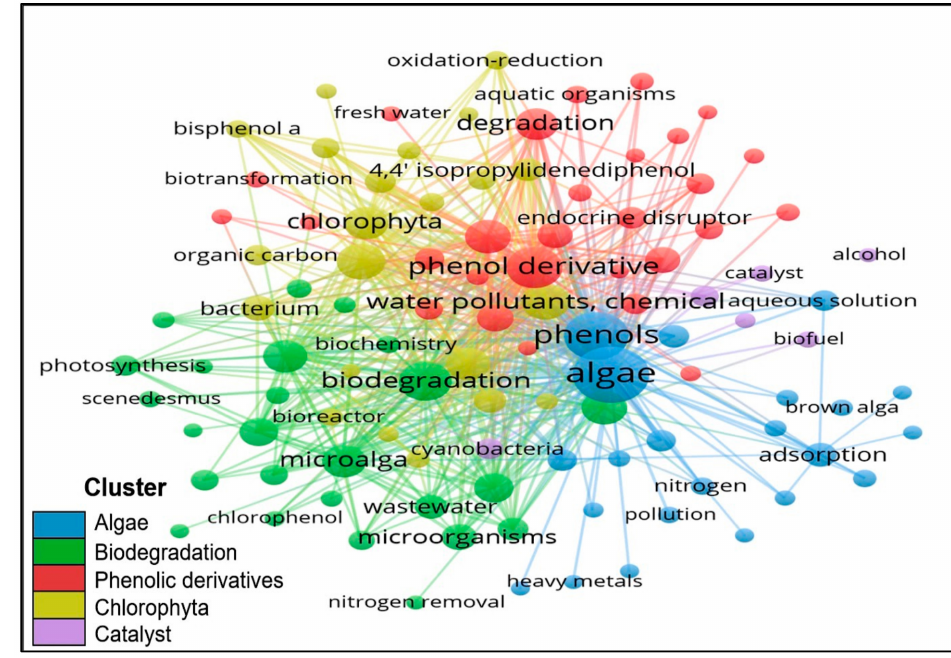
Figure 16. The network visualisation map of co-occurrence term. Table 9. The number of co-occurrence and total strength of the research